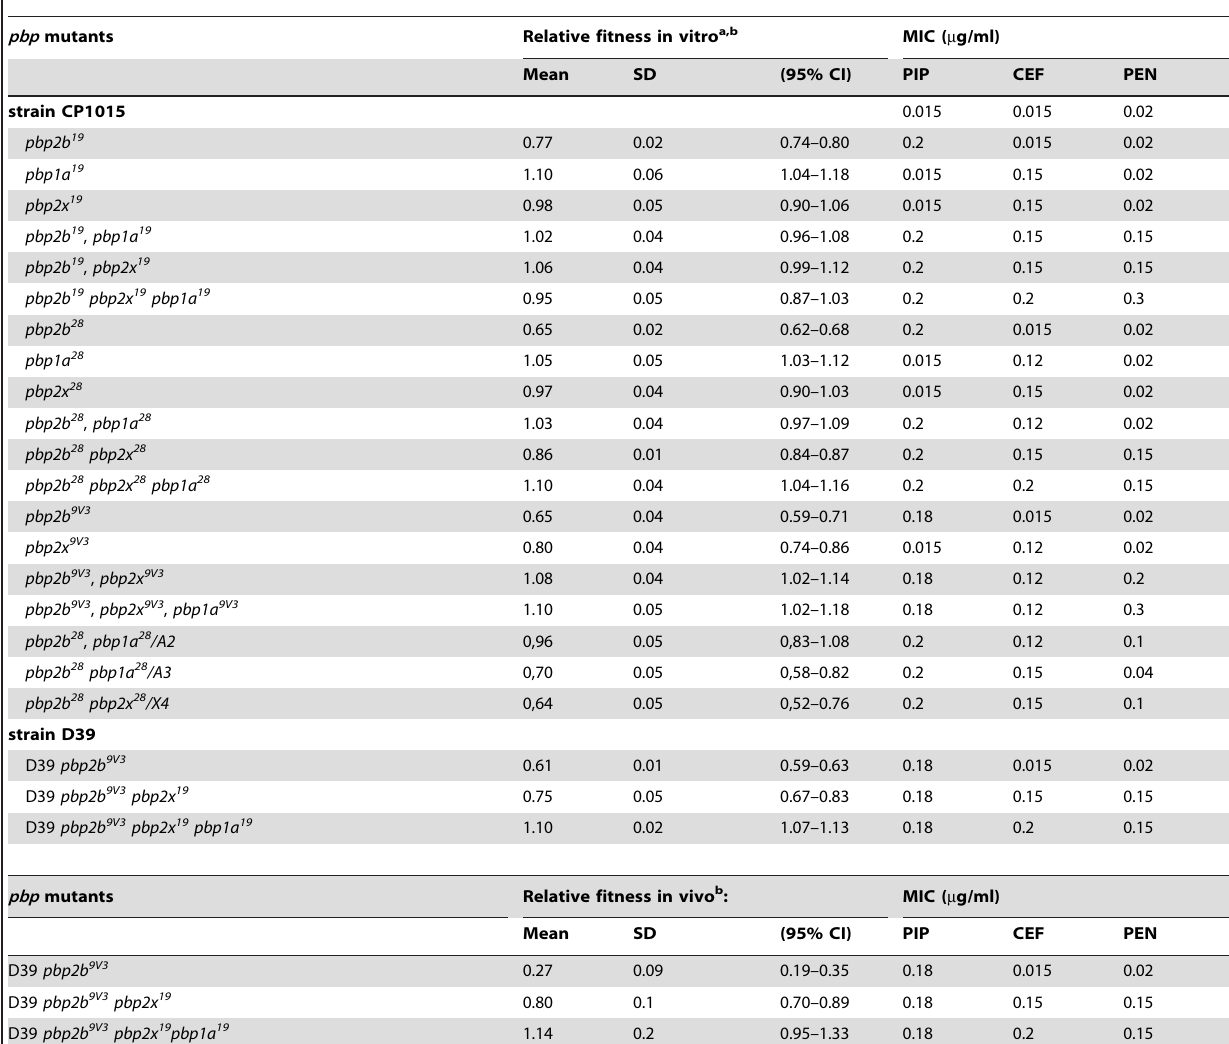
Table 1. Relative competitive fitness of Streptococcus pneumoniae pbp mutants.